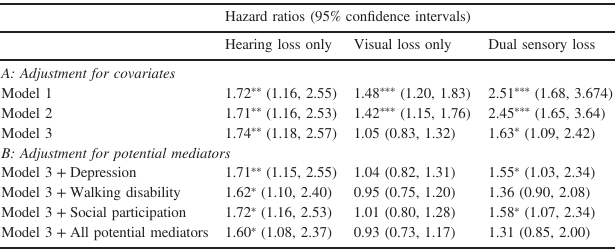
Table 3. The association between sensory loss and cause- speci fi c